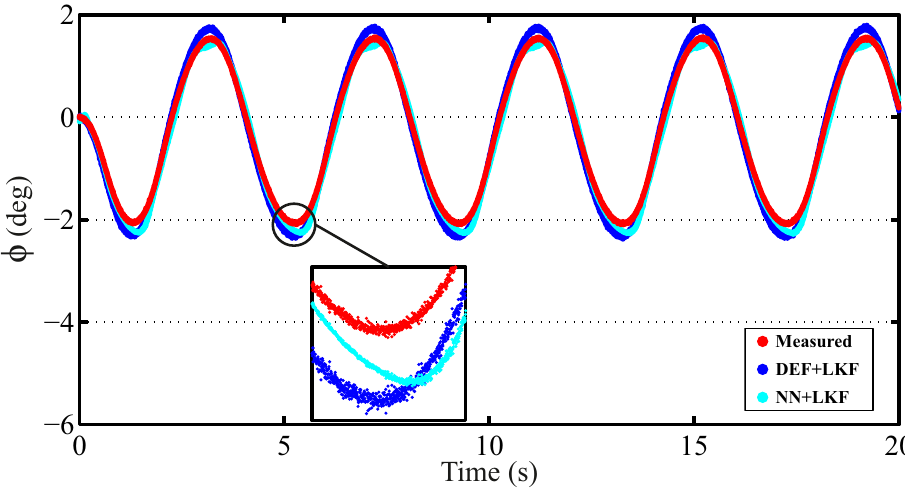
Figure 7. Simulation results for a slalom maneuver at 35 km/h with a friction coefficient of 0.3 (red points: measured; blue points: Deflection (DEF) + Linear Kalman Filter (LKF); cyan points: NN +